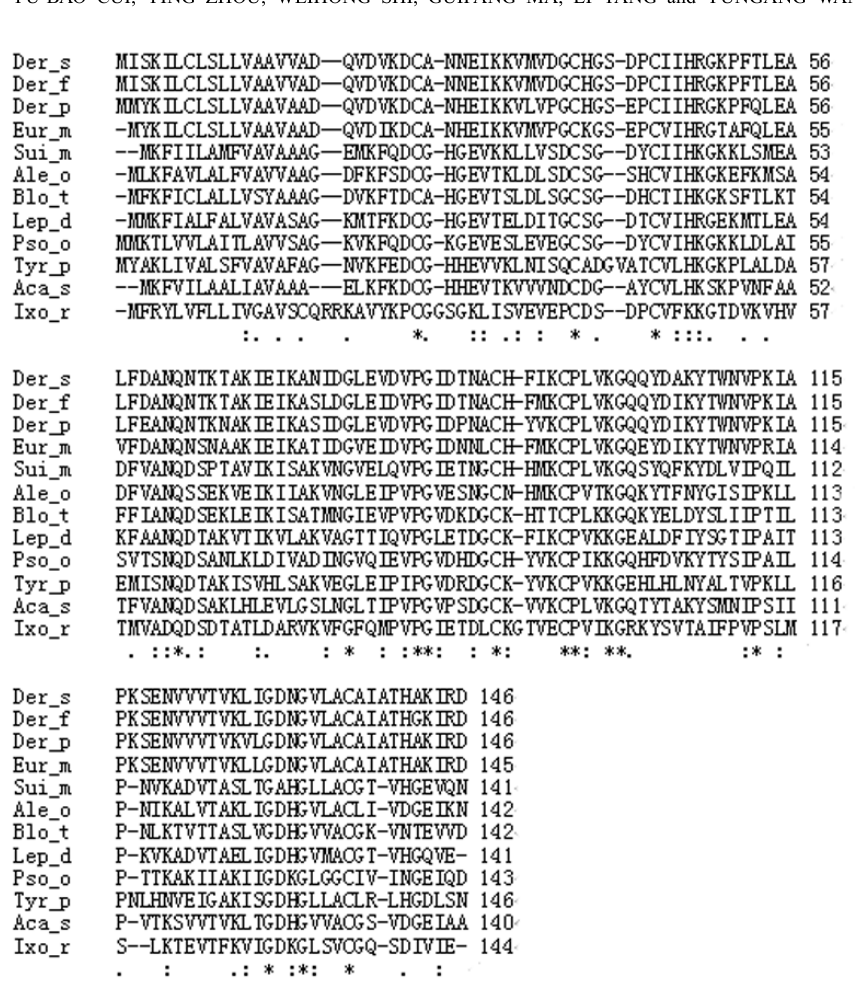
Fig. 4 – Alignment between Der f 2 allergen and its homologous protein fractions from some other species of allergenic mites and ticks by ClustalW2 (http://www.ebi.ac.uk/Tools/clustalw2/). Notes: “ ∗ ” means that the residues or nucleotides in that column are identical in all sequences in the alignment, “ : ” indicates conserved substitutions, “ ∙ ” indicates semi-conserved substitutions. The group 2 allergens of Dermatophagoides farinae , Dermatophagoides siboney , Dermatophagoides pteronyssinus , Suidasia medanensis , Aleuroglyphus ovatus , Blomia tropicalis ,